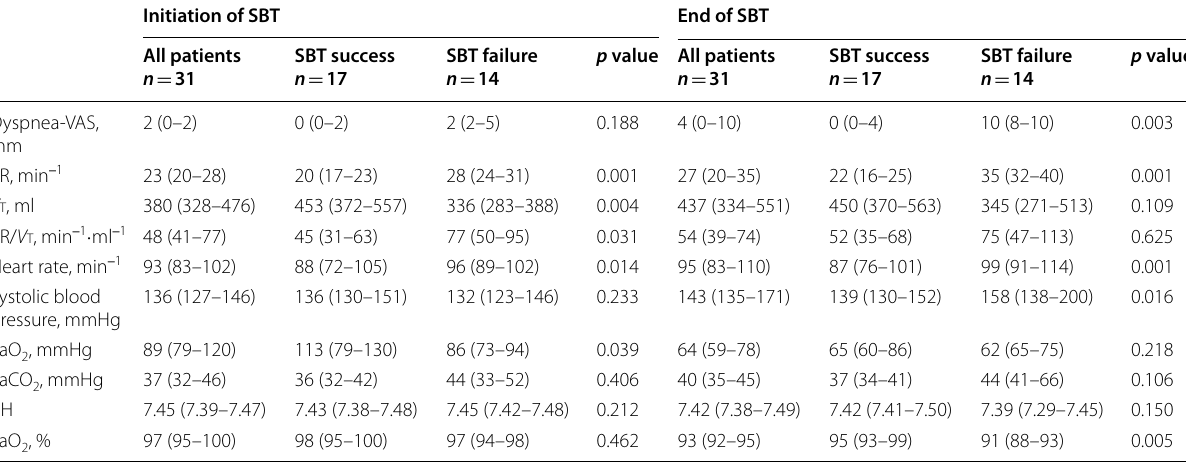
SBT spontaneous breathing trial; Dyspnea-VAS Dyspnea-Visual Analog Scale; RR respiratory rate; V t tidal volume; IBW ideal body weight; SaO 2 arterial saturation of oxygen Data are provided as median (interquartile range) and number (%)